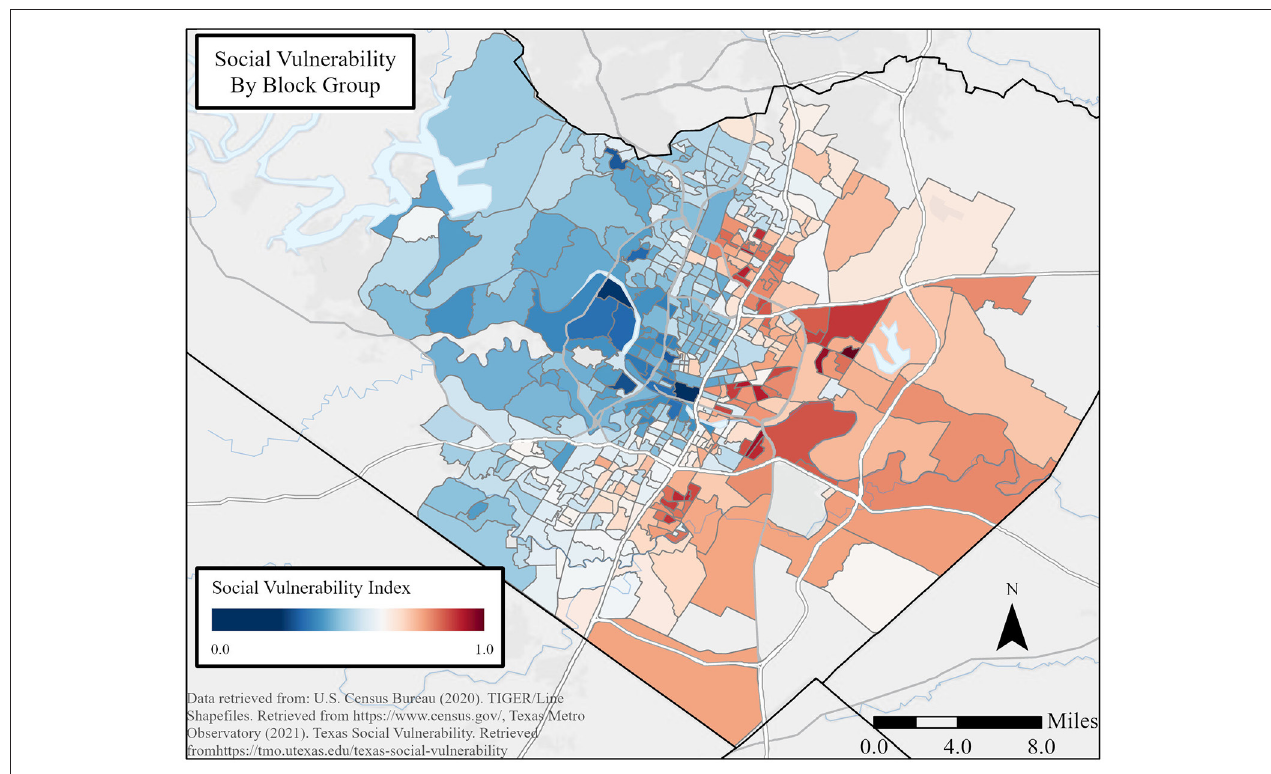
FIGURE 3 | Distribution of social vulnerability index in study